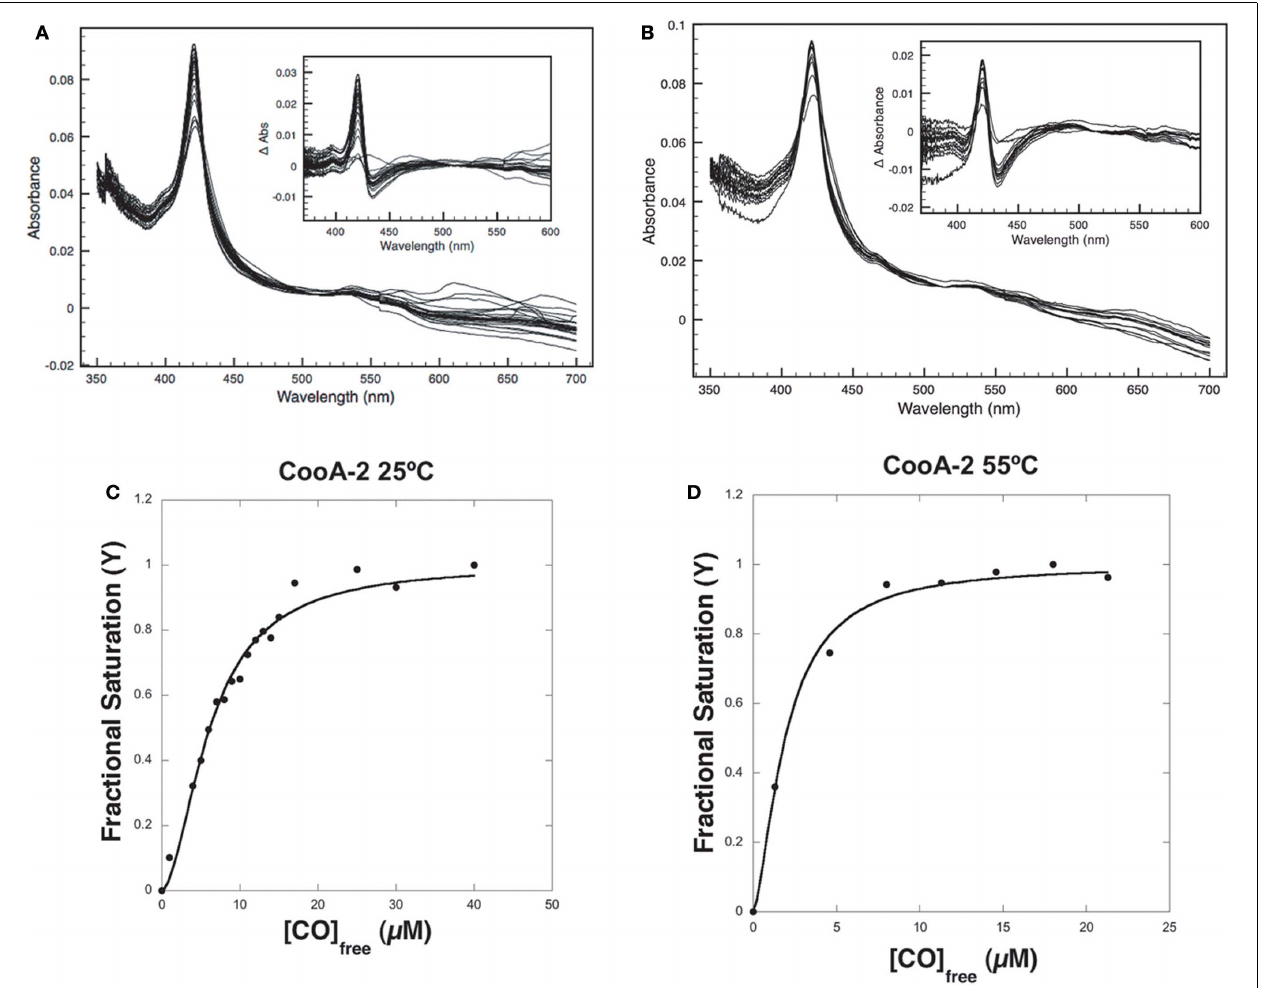
difference between each CO-bound curve and the No-CO curve. Fractional Saturation was plotted against [CO] and fit to the Hill equation for (C) CooA-2 at 25˚C and (D) CooA-2 at 55˚C.